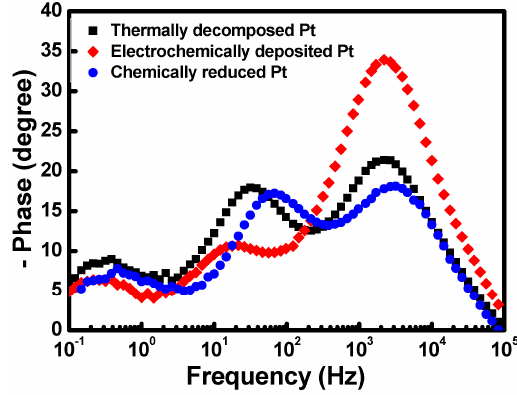
Figure 9. EIS Bode plots of DSSCs based on various Pt CEs.